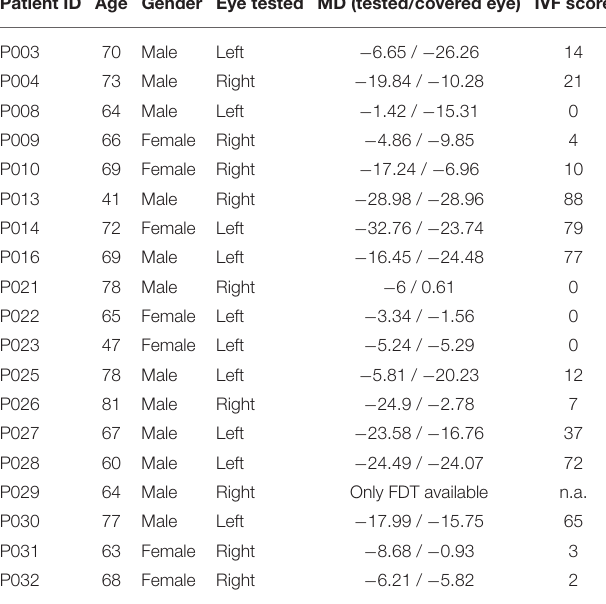
TABLE 2 | This table shows the age, gender, with which eye they performed the experiment, the MD value of the tested and the covered eye and the IVF score of each glaucoma